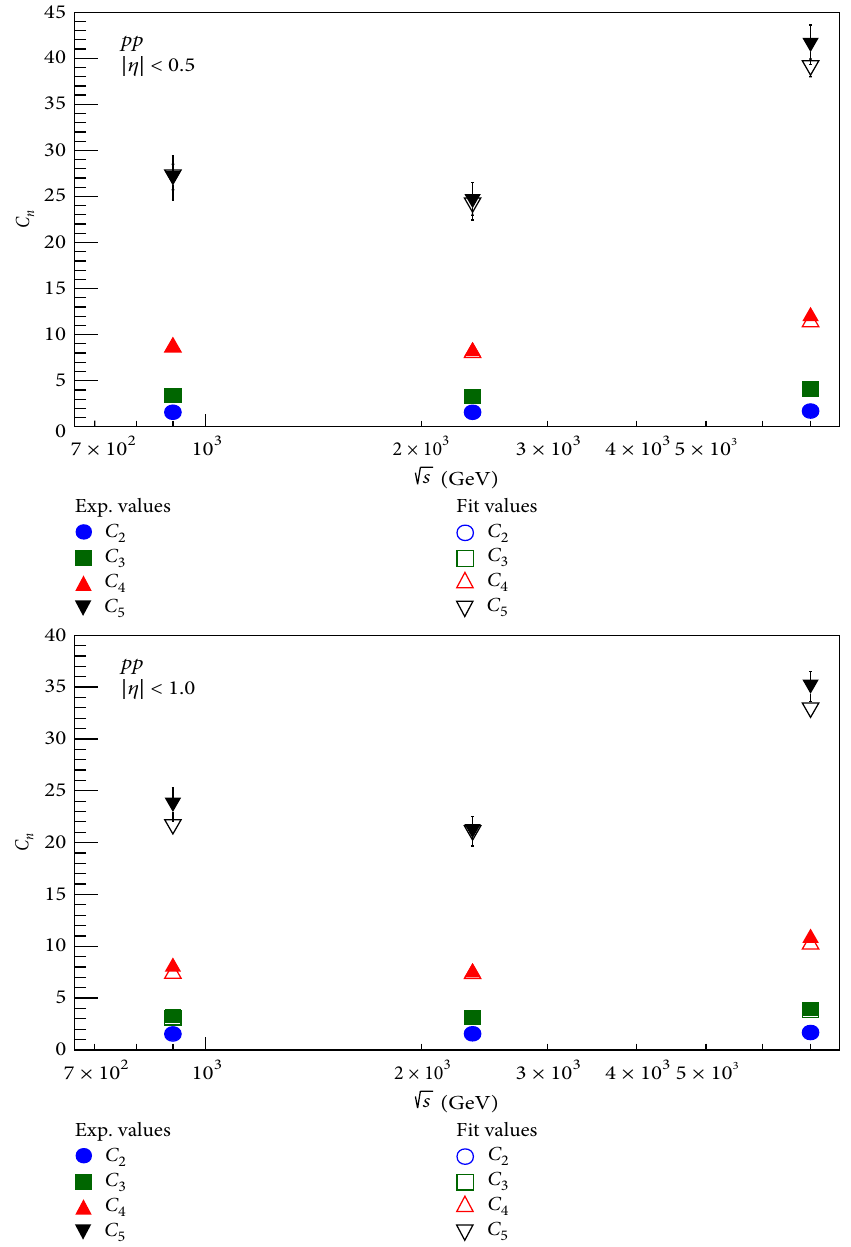
Figure 11: Normalized moments C of modified shifted Gompertz distribution for the pp collisions recorded by the CMS experiment at n different energies and in two pseudo-rapidity bins, | η | < 0.5 and